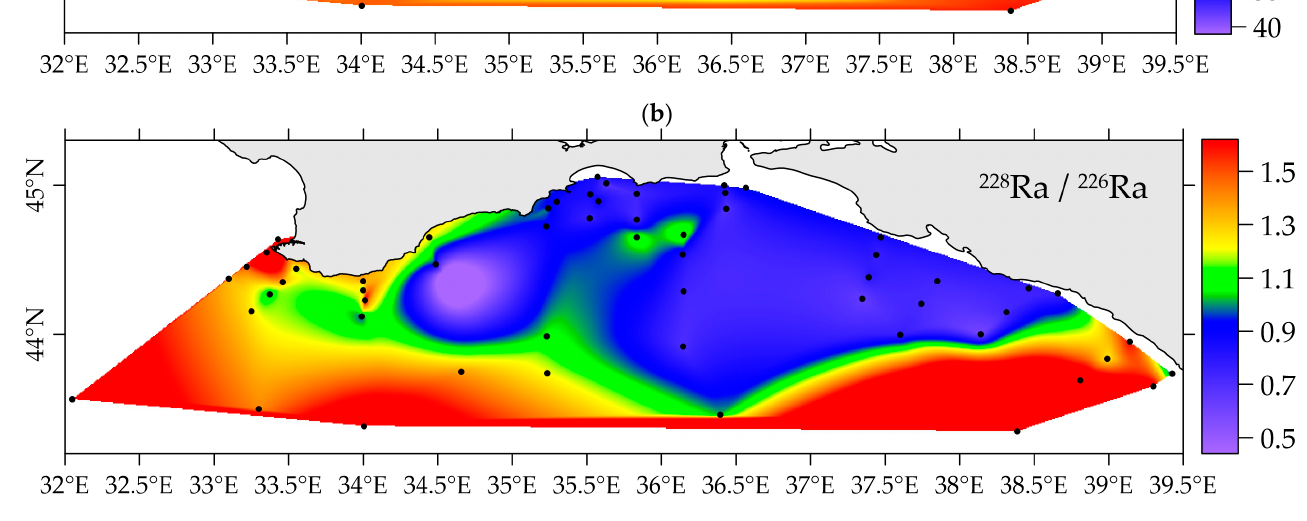
Figure 4. Distribution of 226 Ra ( a ), 228 Ra ( b ) concentration and the ratio of 228 Ra/ 226 Ra ( c ) in the surface layer of the Black Sea in April–May, 2021.